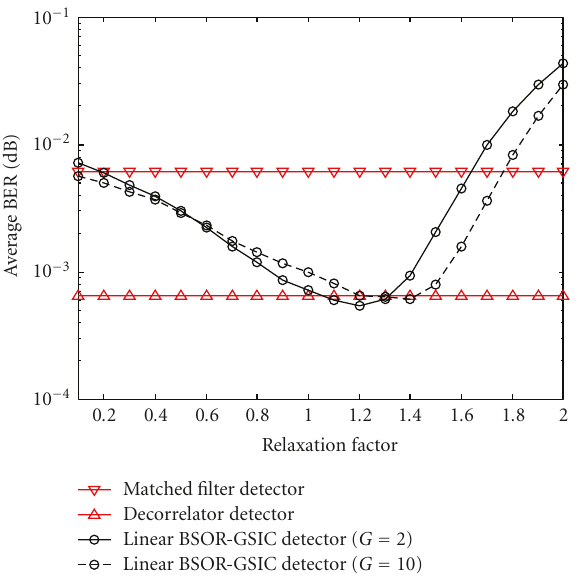
Figure 5: Average BER of the chip-level linear BSOR-GSIC detector versus the relaxation factor.